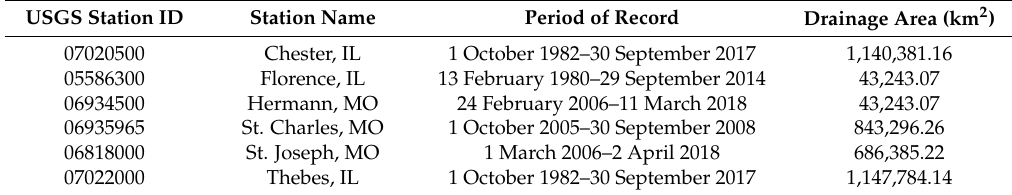
Table 1. Site descriptions of all available USGS suspended sediment monitoring stations within the study